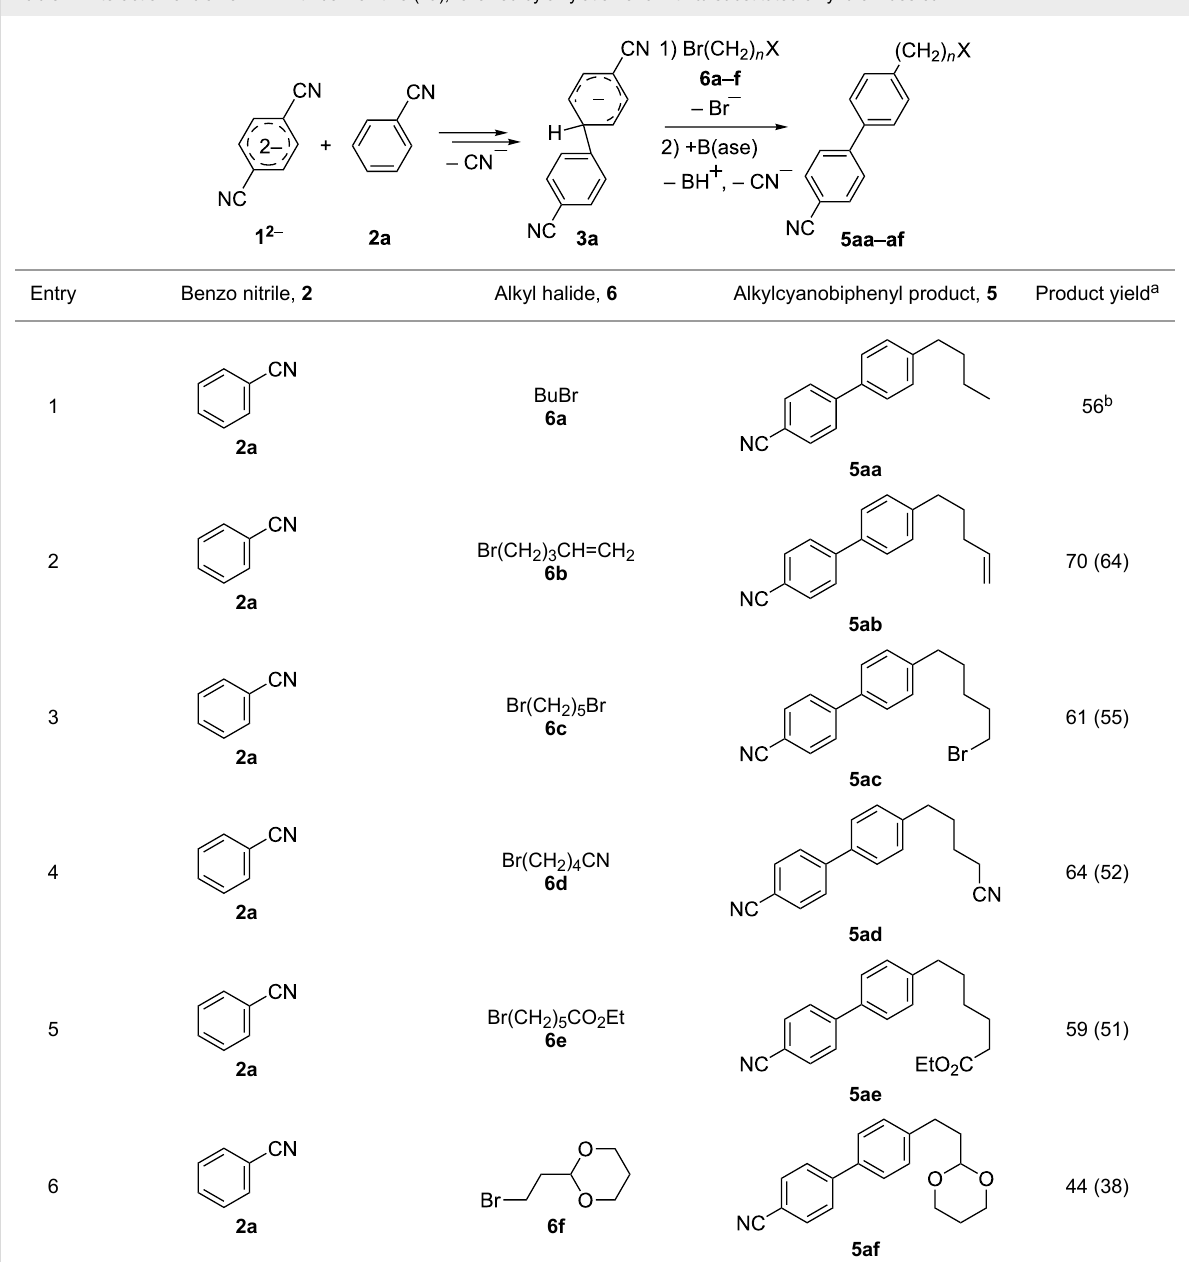
Table 1: Interaction of dianion 1 2 − with benzonitrile ( 2a ), followed by alkylation of 3 with ω -substituted-alkyl bromides 6a – f